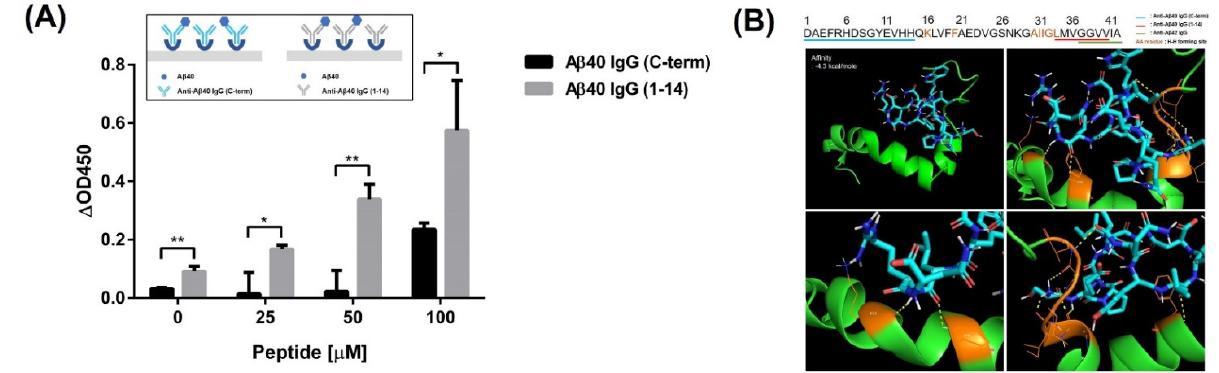
Figure 4. Estimation of the peptide binding sites in A β 42. ( A ) Signal difference of A β 40 between two types of antibodies that recognized different epitopes. Multiple t -test was performed for statistical analysis (* p ≤ 0.05, ** p ≤ 0.01). The test was performed in triplicate under the same conditions. ( B ) Molecular docking analysis of peptide binding to A β 42.